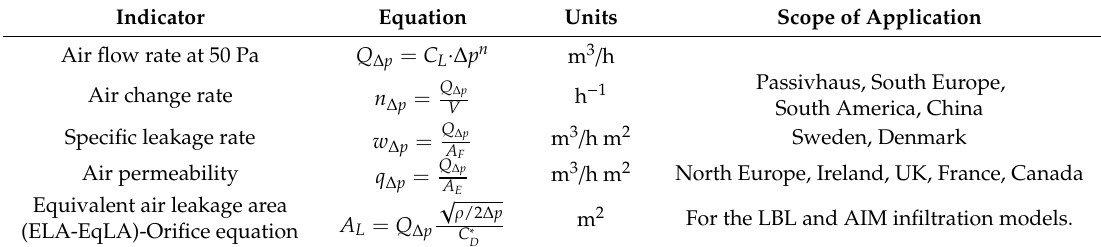
Table 1. Airtightness indicators.